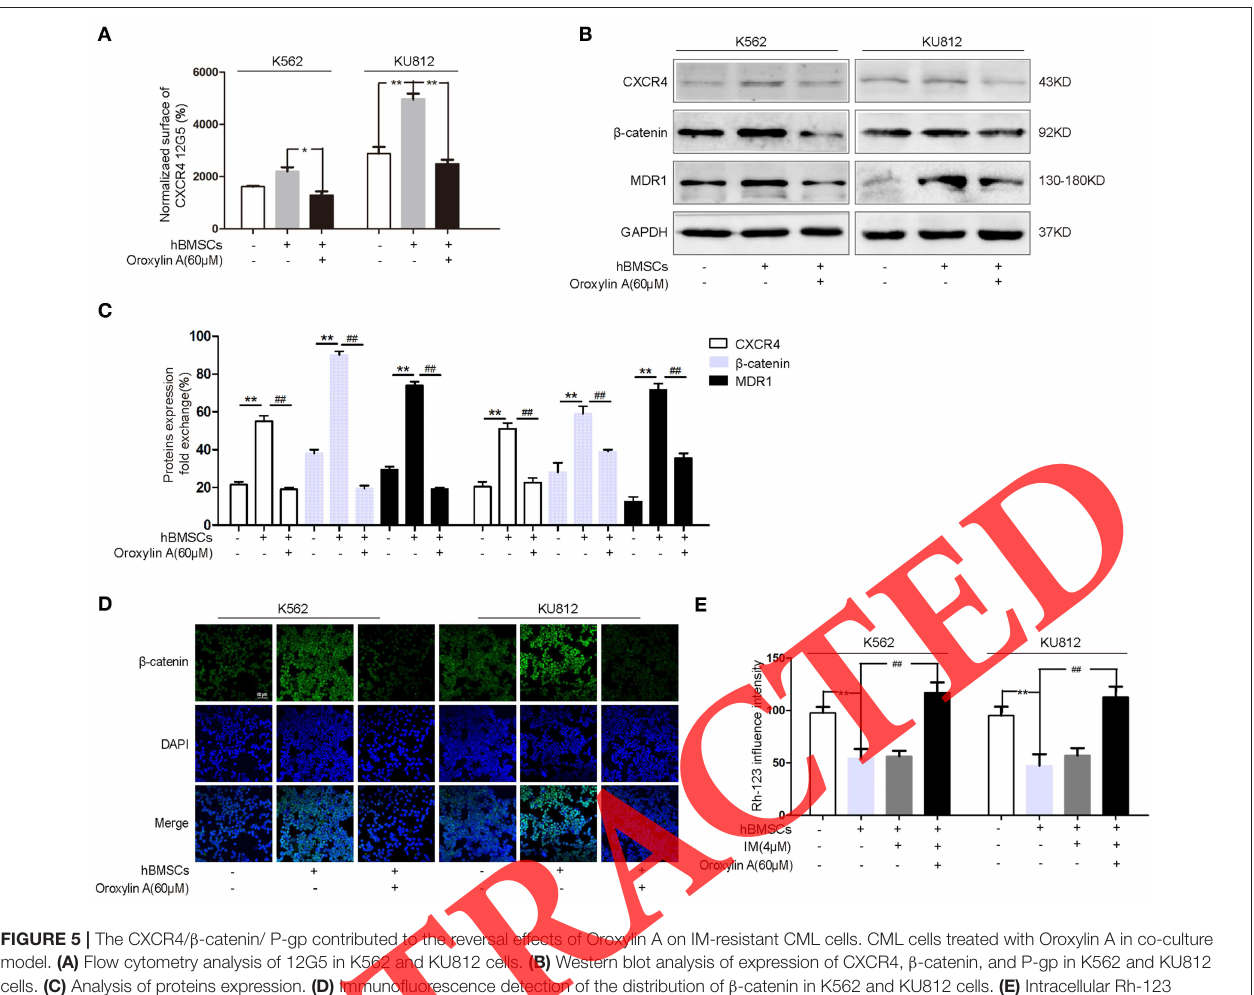
FIGURE 5 | The CXCR4/ β -catenin/ P-gp contributed to the reversal effects of Oroxylin A on IM-resistant CML cells. CML cells treated with Oroxylin A in co-culture model. (A) Flow cytometry analysis of 12G5 in K562 and KU812 cells. (B) Western blot analysis of expression of CXCR4, β -catenin, and P-gp in K562 and KU812 cells. (C) Analysis of proteins expression. (D) Immunofluorescence detection of the distribution of β -catenin in K562 and KU812 cells. (E) Intracellular Rh-123 fluorescence measurement in co-culture model cells treated with IM alone or combination with Oroxylin A. Data were shown as Means ± SD for three independent experiments (* p < 0.05, ** p < 0.01, and ## p <